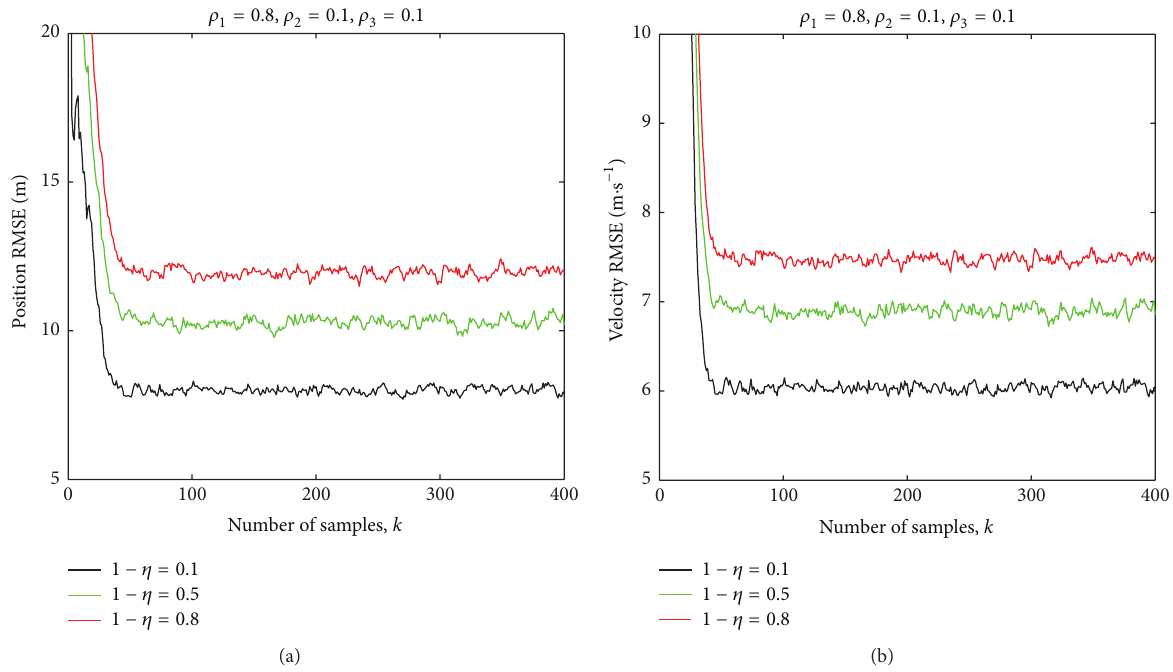
Figure 8: Comparison of the RMSEs for the proposed algorithm with different 𝜌 𝑞 (𝑞 = 1, 2, 3) : (a) position RMSE; (b) velocity